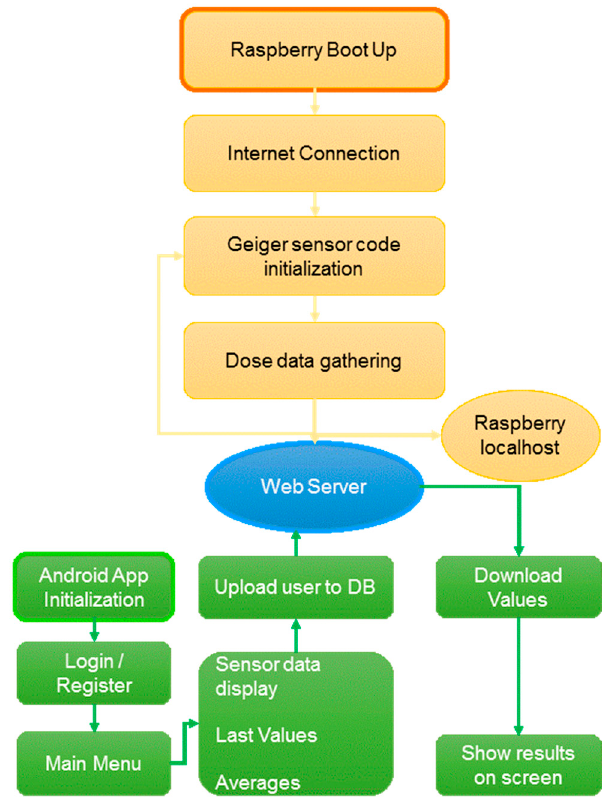
Figure 2. System’s block diagram.